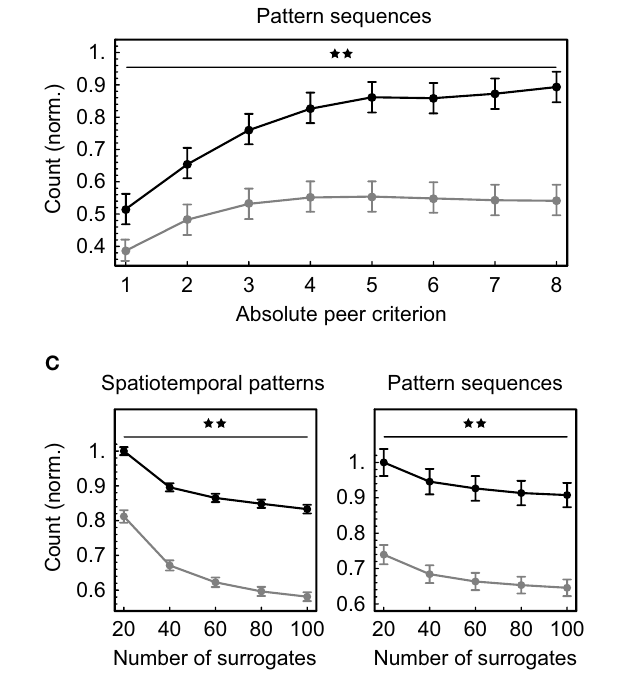
FIGURE 7 | Dependence of the number N of significant patterns and pattern sequences on analytical parameters. Multineuronal spiking activity was scanned for spatiotemporal patterns using 30 different definitions given by ten different time windows W (5, 10, 15, 20, 25, 30, 35, 40, 45, and 50ms) and three different relative timing precisions (10 bins, 5 bins, and rank order).The numbers of significant patterns and sequences were normalized to be comparable across data sets (mean ± SEM across 10 data sets and 30 pattern definitions). Stars denote a significant difference between original and surrogate data ( (cid:2) p < 0.004, (cid:2)(cid:2) p < 0.00007, exact binomial test). (A) Counts depending on the